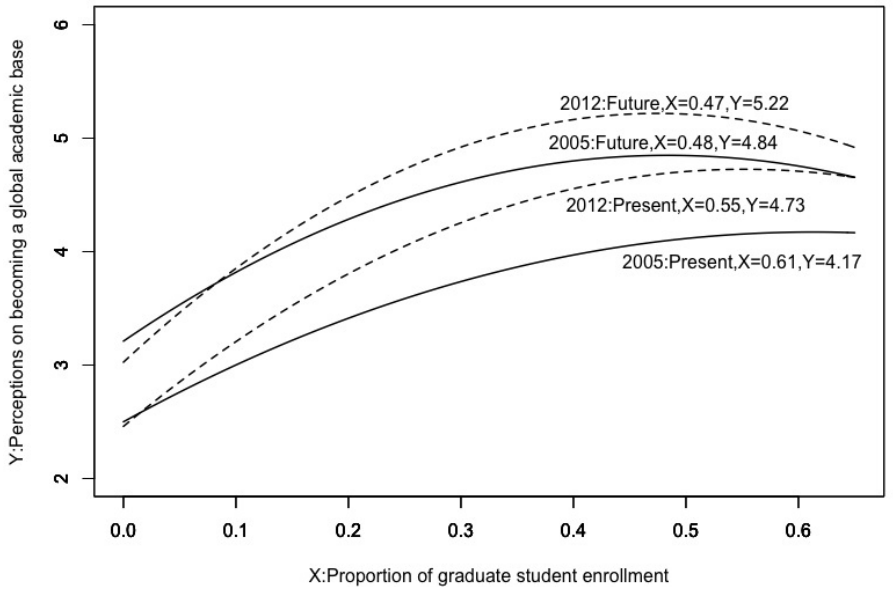
Figure 2. Self-assessment of Japanese university executives on becoming a global knowledge base and the proportion of graduate